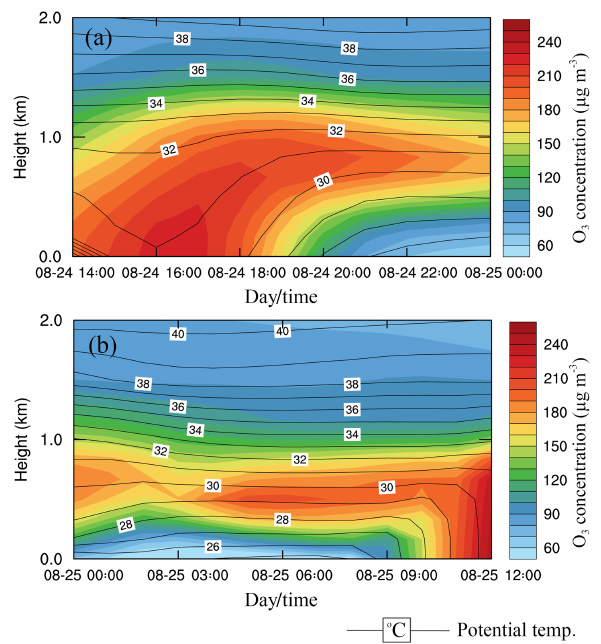
Figure 4. Time–altitude cross sections of O 3 concentrations and potential temperature over (a) the eastern YRD area covering the CZ, WX, SZ and SH sites from 14:00 on 24 August to 00:00 on 25 August, and (b) the western YRD NJ site from 00:00 to 12:00 on 25 August